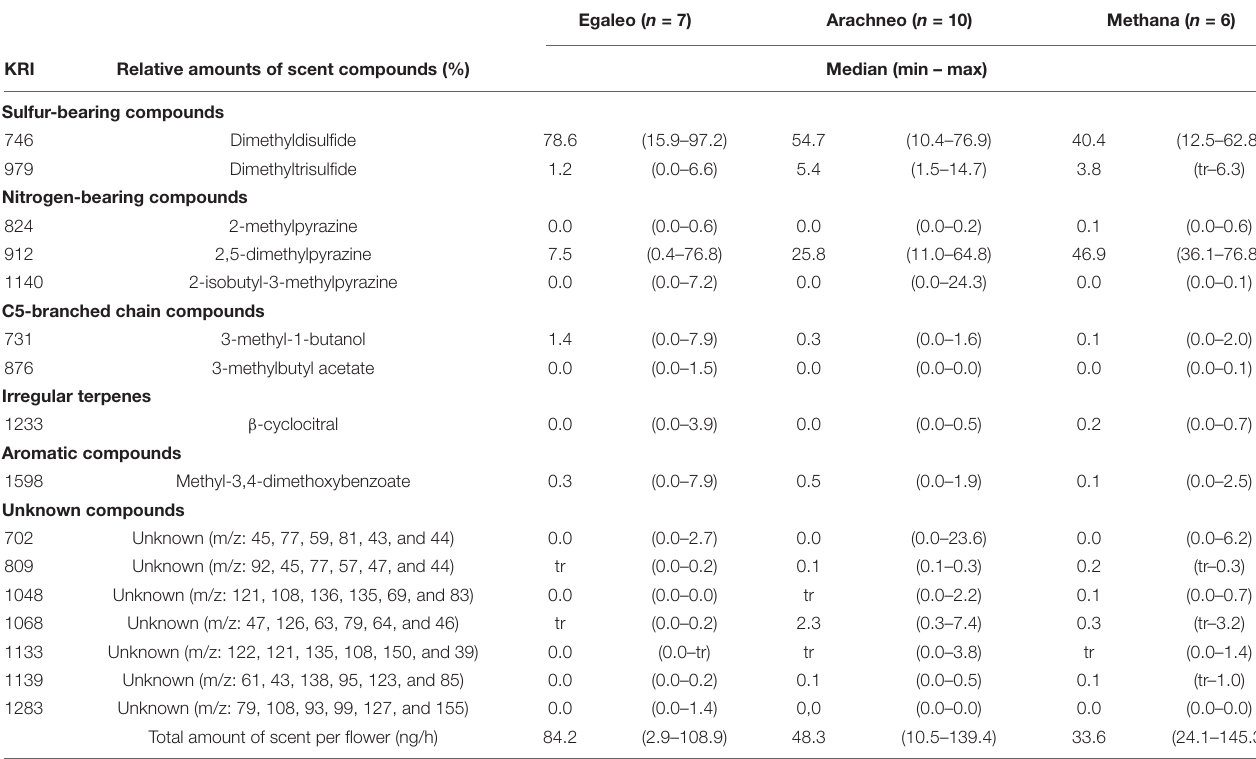
TABLE 1 | Median relative (%) and total absolute (ng/h) amounts of scent (compounds) emitted by single female phase Aristolochia microstoma flowers, collected at three natural sites in Greece: Egaleo, Arachneo, and